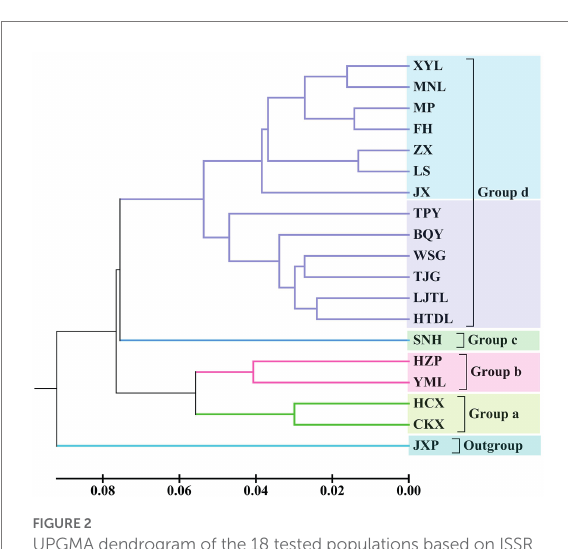
FIGURE 3 UPGMA dendrogram of the 18 tested populations based on cpDNA.